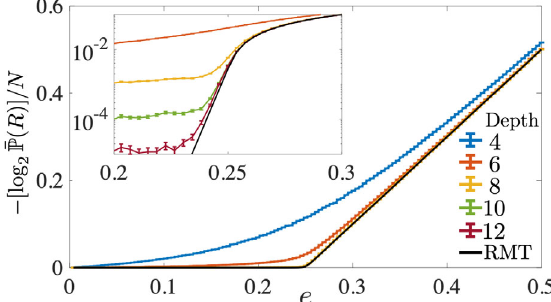
FIG. 5. Recovery probability vs erasure fraction for a two- dimensional random circuit in a brickwork arrangement of gates with periodic boundary conditions for different depths d for N ¼ 256 and R ¼ 1 = 2 . Different sizes collapse to the same curve for this way of scaling except within a region of width j e − e 1 =N near the critical point. We sequentially cycle through four layers so that each site interacts with its north, east, south, and west neighbors for each four units of depth. The scaling behavior converges to the RMT prediction exponentially with depth throughout the critical region. The inset shows the same data on a logarithmic scale, illustrating the scaling P ð F Þ ∼ e − d=A for e < e . Each two-qubit gate in the circuit consists of an iSWAP c gate followed by a random single-site Clifford on each